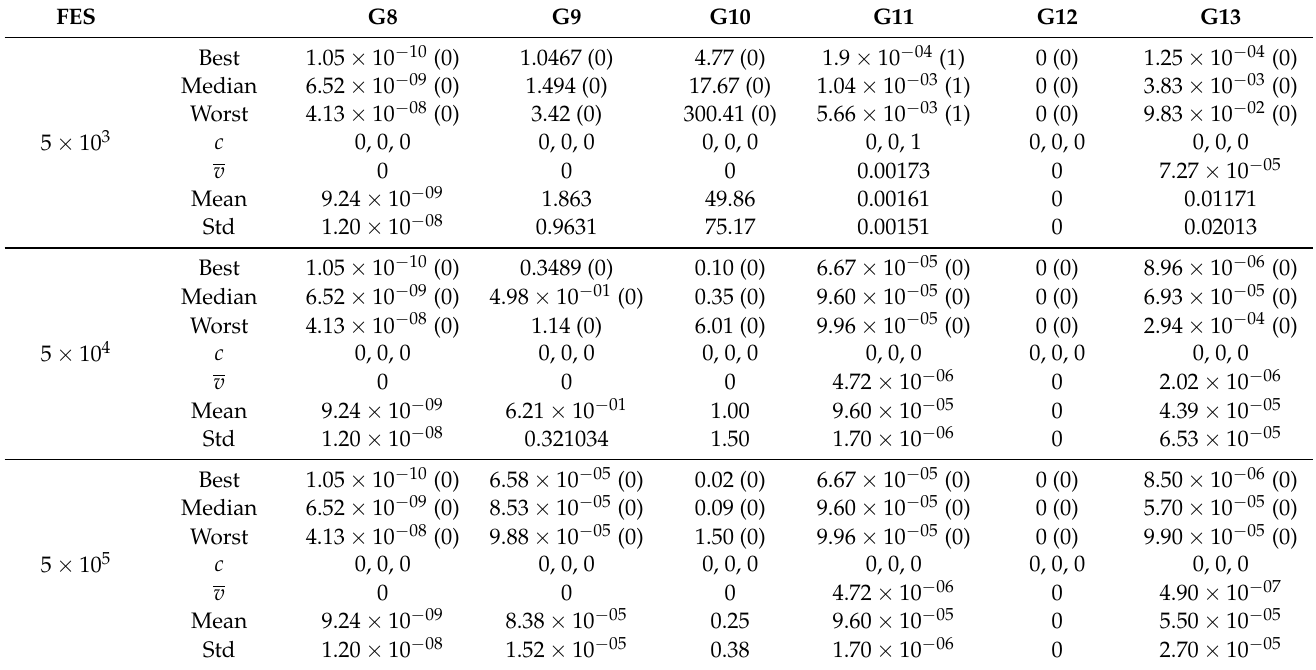
Table 3. Error values achieved when FES = 5 × 10 3 , FES = 5 × 10 4 , FES = 5 × 10 5 for Problems G8, G9, G10, G11, G12 and G13.